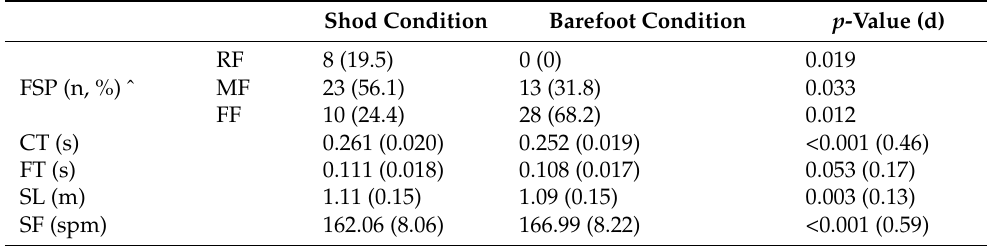
Table 1. Spatiotemporal gait characteristics during running shod and barefoot at comfortable velocity. Shod Condition Barefoot Condition